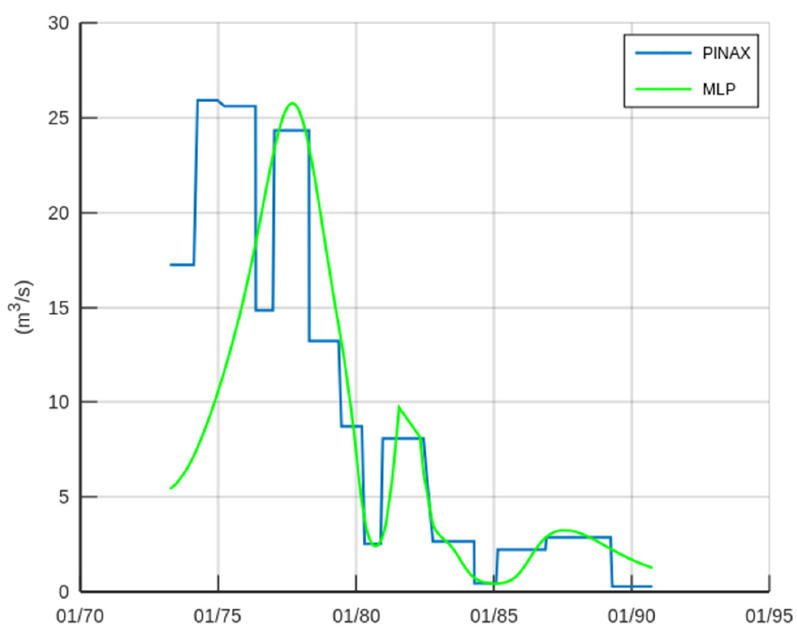
Figure 9. Trikeriotis case study—discharge calculated with the MLP and discharge calculated with the 14 PINAX ‐ obtained regressions. The start and end of these 14 periods are marked with the dashed vertical lines.